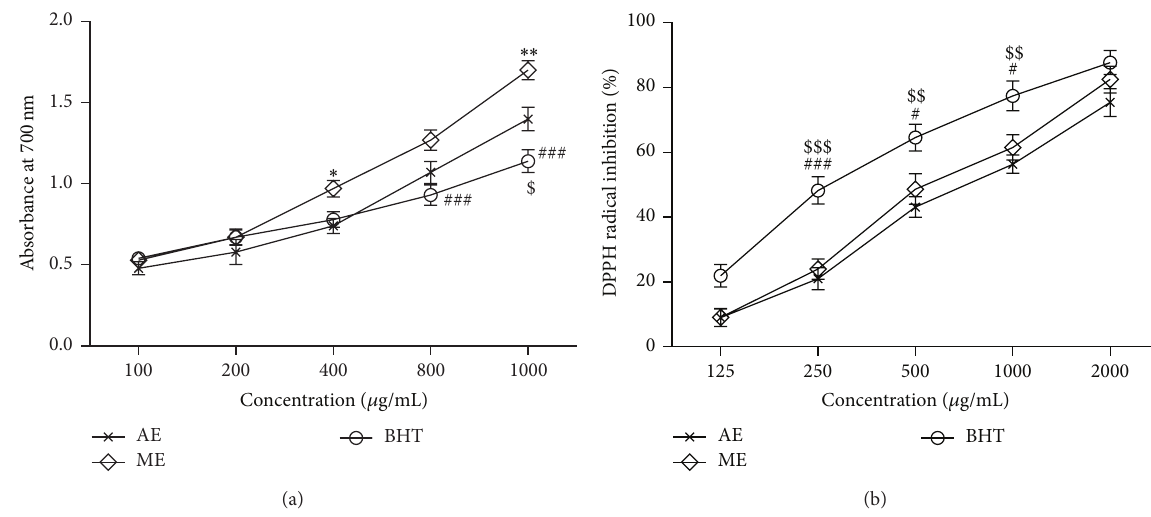
Figure 3: (a) Ferric reducing power, (b) DPPH radical scavenging activity of BHT, AE, and ME seed extracts of Abelmoschus esculentus . Data are representative of three independent experiments. Values are mean ± S.E.M. The significance of differences was analysed by two-way ANOVA followed by Bonferroni multiple comparisons test (AE versus ME, ∗ 𝑃 < 0.05 ; ∗∗ 𝑃 < 0.01 ; ME versus BHT, # 𝑃 < 0.05 ; ### 𝑃 < 0.001 ; AE versus BHT, $ 𝑃 < 0.05 ; $$ 𝑃 < 0.01 ; $$$ 𝑃 < 0.001 ). (a) Treatment: F (2, 30) = 20.62, 𝑃 < 0.0001 ; concentration: F (4, 30) = 122.39, 𝑃 < 0.0001 ; interaction (treatment × concentration): F (8, 30 = 4.79, 𝑃 < 0.001 ). (b). Treatment: F (2, 30) = 35.82, 𝑃 < 0.0001 ; concentration: F (4, 30) =